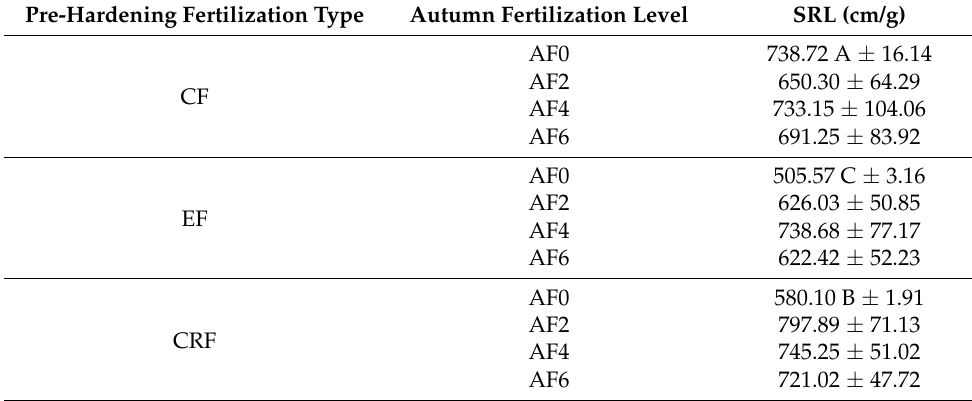
Table 5. Effects of pre-hardening fertilization type and autumn fertilization level on specific root length (SRL) (mean ± SE) of Pinus koraiensis seedlings at the end of experiment. Different capital letters indicate a significant effect of S:R among pre-hardening fertilization types ( p < 0.05). Means were compared using Duncan’s